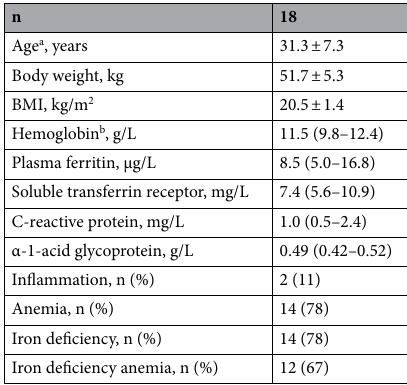
Table 1. Baseline characteristics of the Thai women (n = 18) participating in the iron absorption study. a Mean ± standard deviation (all such values). b Median; interquartile ranges in parentheses (all such